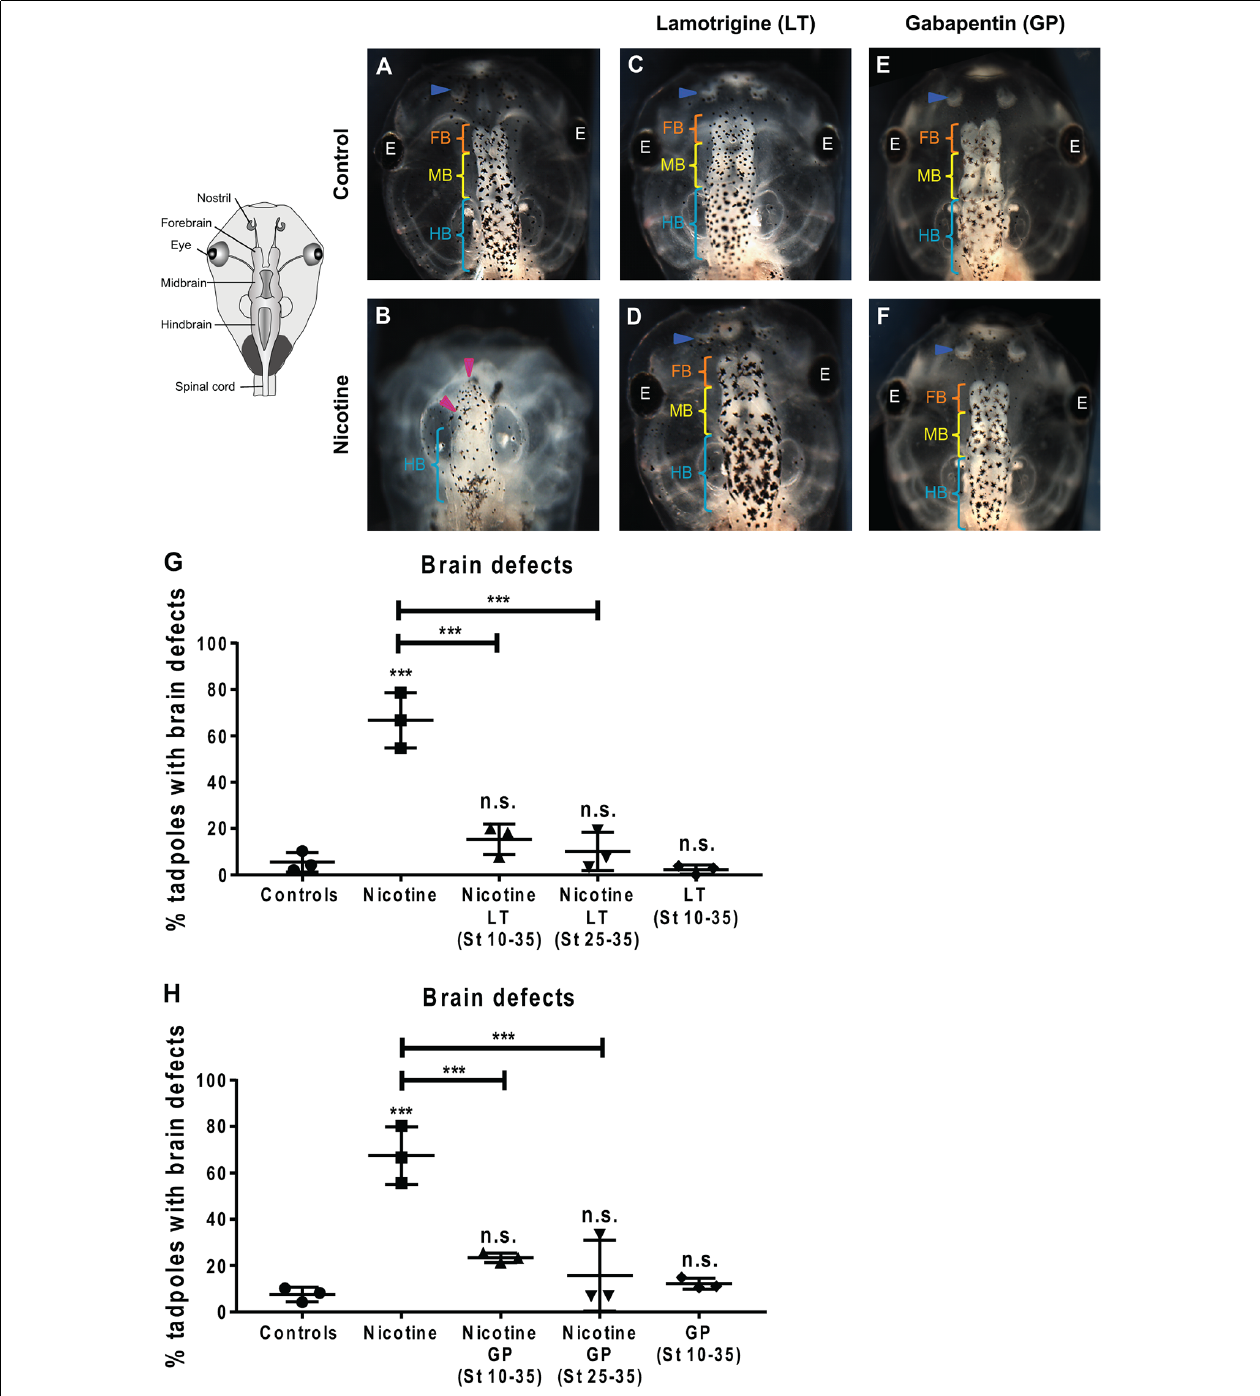
FIGURE 7 | Non-local exposure to Lamotrigine and Gabapentin (HCN channel agonist) rescues nicotine-induced brain morphology defects in Xenopus embryos. (A—F) Representative images of stage 45 tadpoles. Control (untreated and uninjected) or nicotine-treated tadpoles with or without treatment with lamotrigine (LT, stage 10–35) or gabapentin (GP, stage 10–35). Blue arrowheads indicate intact nostrils, orange brackets indicate intact forebrain (FB), yellow brackets indicate intact midbrain (MB), cyan brackets indicate intact hindbrain (HB), and magenta arrowheads indicate severe brain morphology defects. (G,H) Quantification of stage 45 tadpole brain morphology defects under the indicated conditions for lamotrigine (LT; G ) or gabapentin (GP; H ). Percentage of tadpoles with brain defects for each experimental group are: (G) Controls—5%, Nicotine—67%, Nicotine+LT (St10–35)—15%, Nicotine+LT (St25–35)—10%, and LT(St 10–35)—2%; ( H ) Controls—7%, Nicotine—68%, Nicotine+GP (St10–35)—23%, Nicotine+GP(St25–35)—16%, and GP(St 10–35)—11%. Data are mean ± SD, *** p < 0.001, n.s.: non-significant (one-way ANOVA with Tukey’s post hoc test for n = 3 independent experiments with N > 50 embryos per treatment group per experiment).